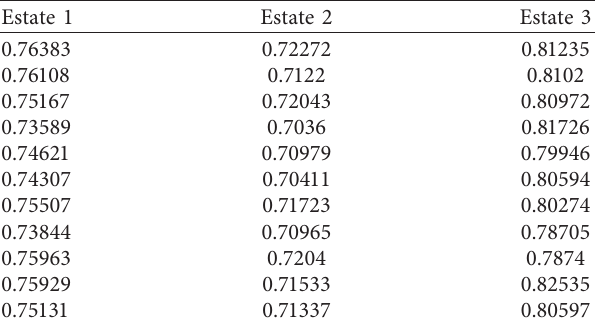
Table 5: Area under the ROC